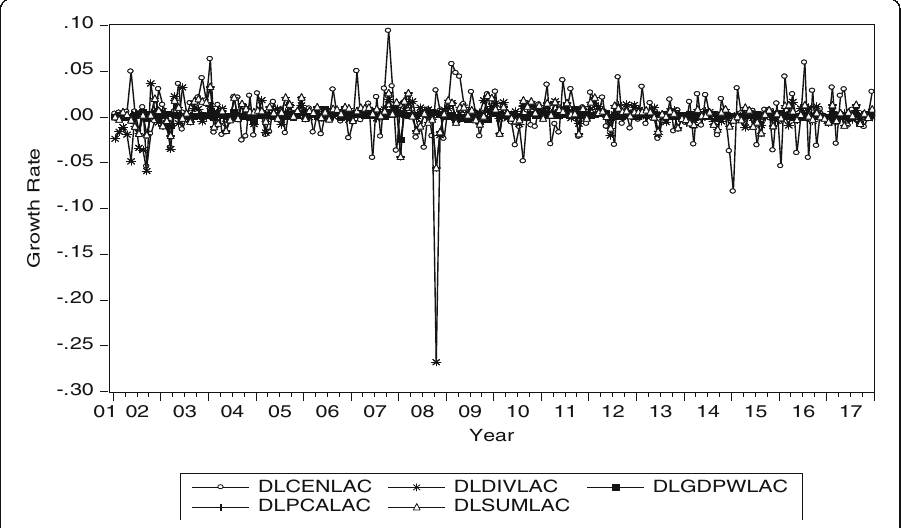
Fig. 3 Monthly Growth Rates of Monetary Aggregates of Latin America and the Caribbean. DLCENLAC, DLDIVLAC, DLGDPWLAC, DLPCALAC and DLSUMLAC are log differences of CE, Divisia index, GDP-weighted, PCA-based, and Simple-Sum measures for Latin America and the Caribbean respectively. The numbers 01 through 17 on the horizontal axis represent the years 2001 through 2017